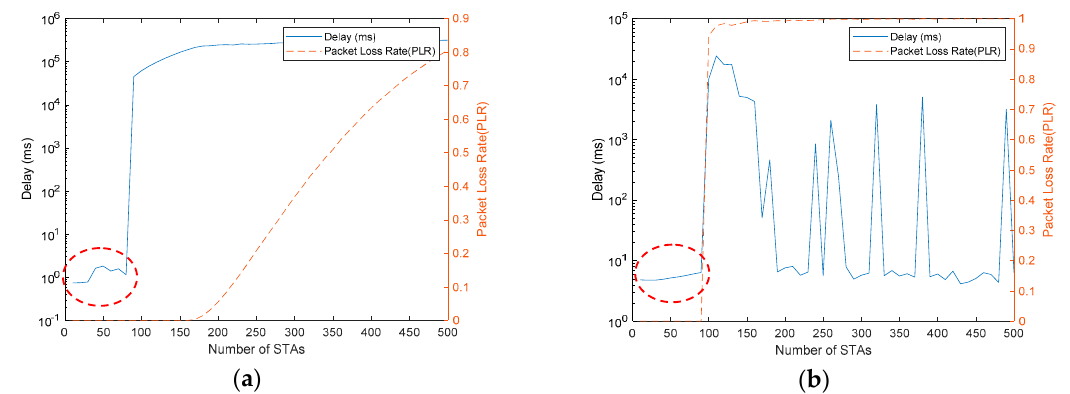
Figure 11. Average delay and PLR in a single band transmission case (dashed circle is the converged delay range): ( a ) Conventional IEEE 802.11p channel access scenario; ( b ) Proposed V2X-UORA channel access scenario.